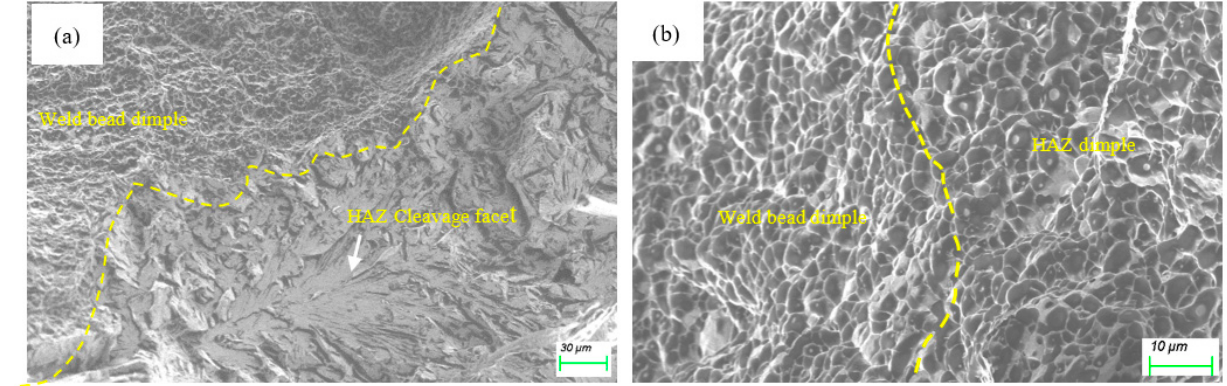
Figure 11. Fractograph of ( a ) the as-welded and ( b ) the